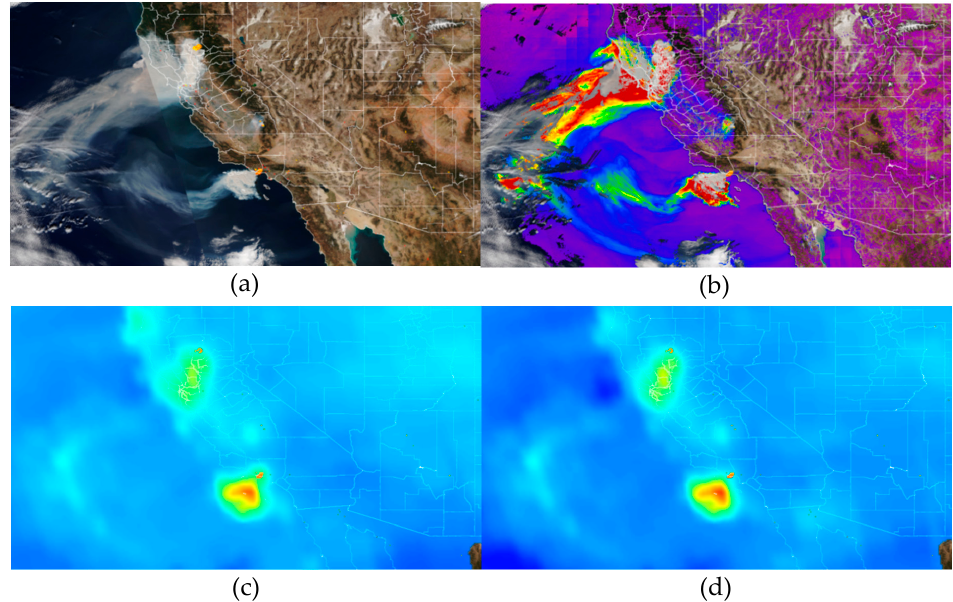
Figure 12. JPSS products captured severe California fire in November 2018: ( a ) VIIRS Active Fire; ( b ) VIIRS AOD; ( c ) CrIS/NUCAPS CO at 500 mb; ( d ) CrIS/NUCAPS CO at 700 mb. (Figures from JSTAR Mapper website